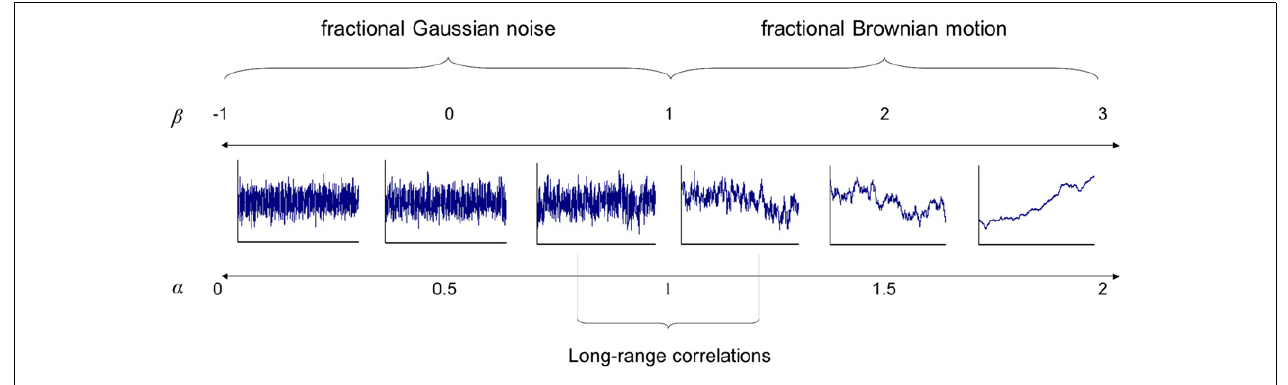
Brownian motion to β = 2 and α = 1.5. Long-range correlations are considered to appear between β = 0.5 and β = 1.5. β = α = 1 corresponds to ideal 1/ f